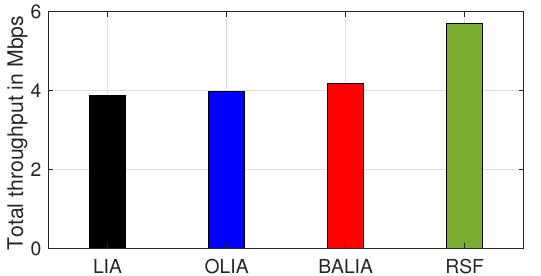
Figure 9. Throughput results for Scenario 8: path failure. Both paths had 20 Mbps bandwidth, 150 ms delay, and 2% packet loss probability. One path (WiFi) became unavailable at 50 s.